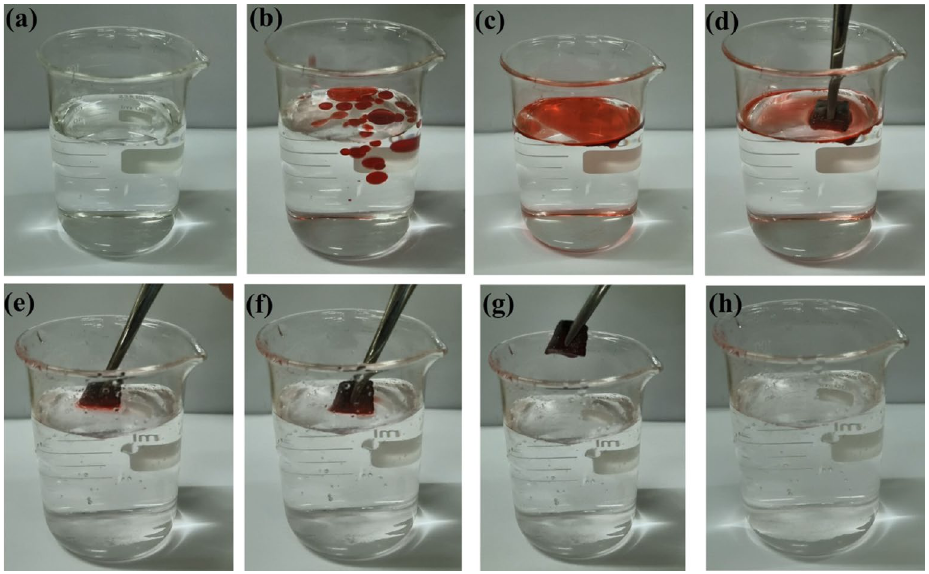
Figure 8. Digital photographs of oil spill absorbing floated on the